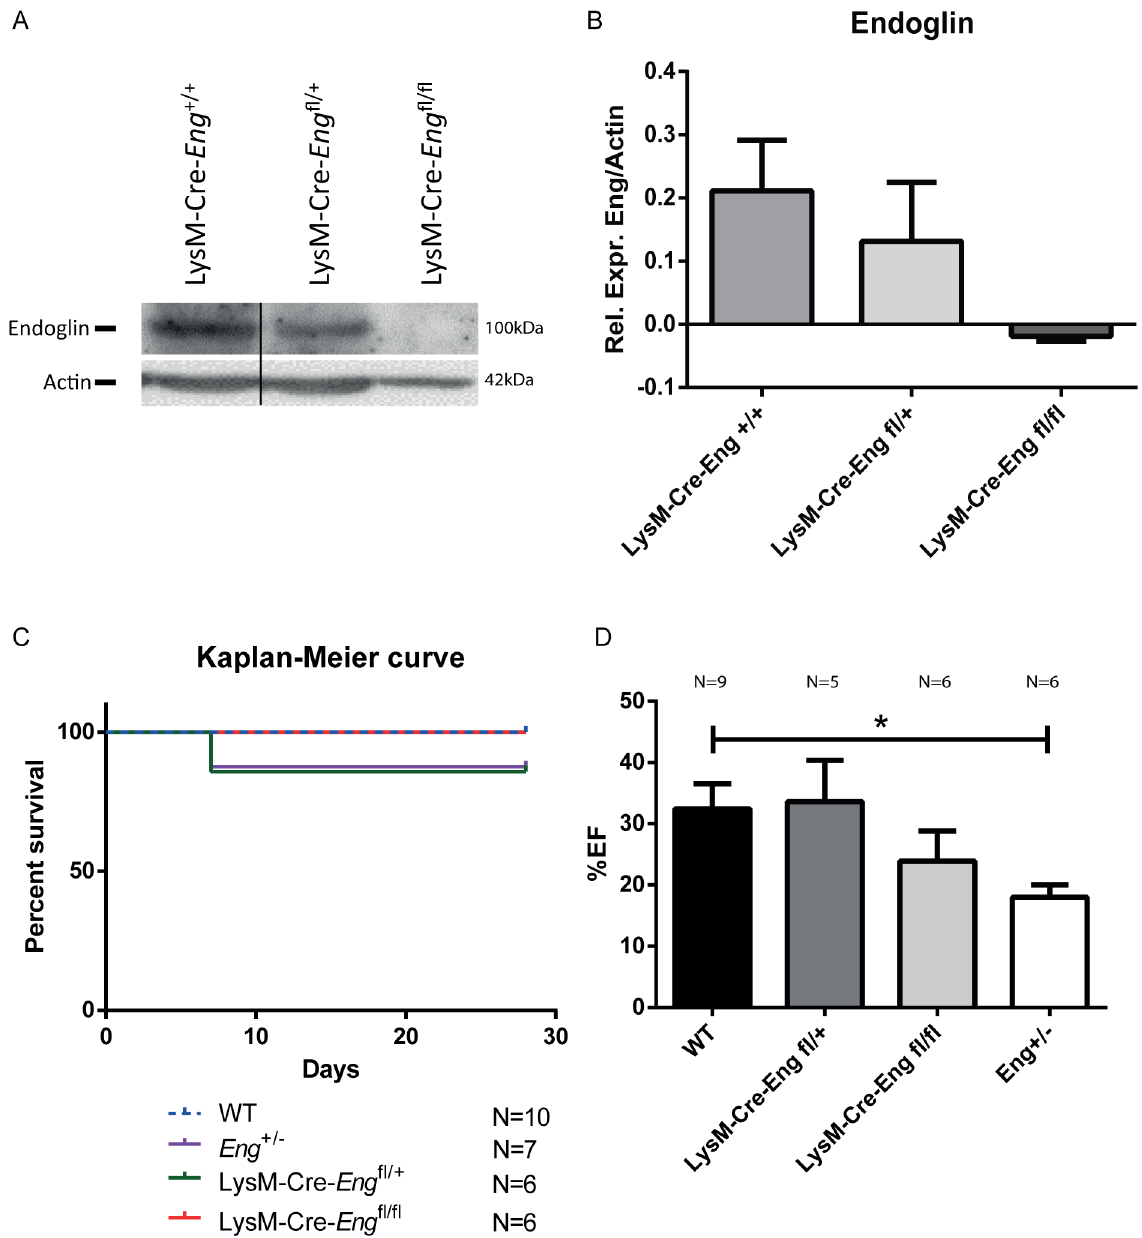
Fig 1. Monocyte specific knock-out of endoglin does not recapitulate the Eng +/- phenotype. (A) Western blot analysisof endoglinprotein expressionin LysM-Cre- Eng +/+ , LysM-Cre- Eng fl/+ and LysM-Cre- Eng fl/fl cultured macrophages. A representative experiment is shown. (B) Quantification of the Western blots for endoglinprotein in LysM-Cre- Eng +/+ , LysM-Cre- Eng fl/+ and LysM-Cre- Eng fl/fl culturedmacrophages in two independentexperiments(macrophage cultures from 3 individual mice of each genotypewere pooledper western blot). (C) Kaplan-Meier survival curve of wild type (WT), LysM-Cre- Eng fl/+ and LysM-Cre- Eng fl/fl mice 28 days post-MI (n = 6–10). (D) Cardiacfunction in percentageejectionfraction (%EF) 14 days post-MI. Cardiacfunction was measuredby ultrasound in long axis view (n = 5–9). Data are shown as mean ± SEM, * P < 0.05. 12.34±1.64%, P < 0.0001). After DipA treatment, there was a significant increase in the percent- age of M2 macrophages within the total population of macrophages in both wild type and Eng +/- mice, and consequently a decrease in M1 macrophages. Importantly, DipA was able to